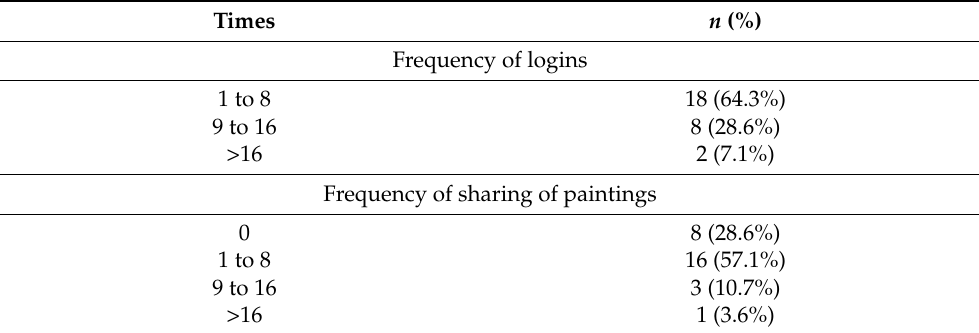
Table 2. Frequency of logins and sharing of